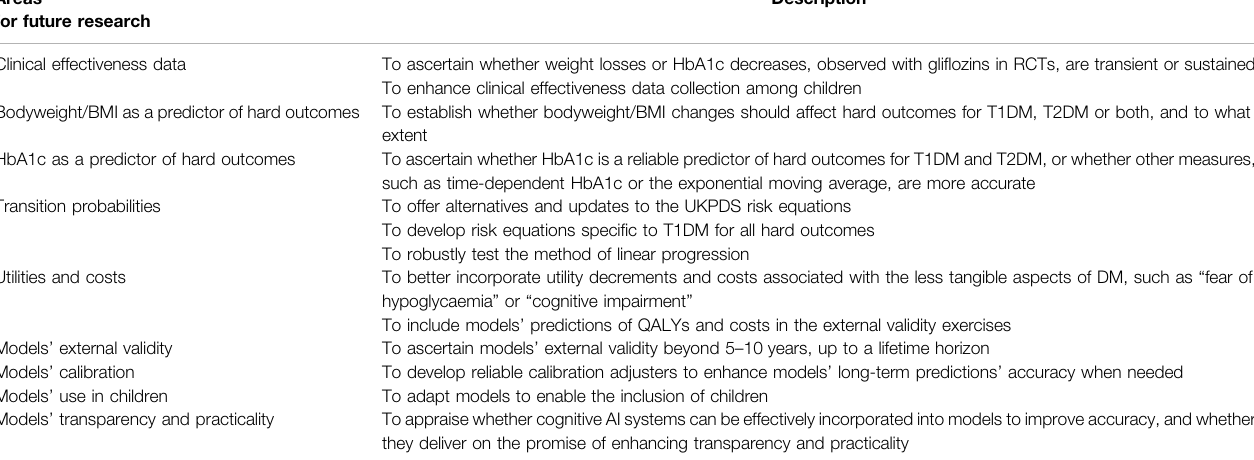
TABLE 4 | Areas for future research for T1DM and T2DM economic